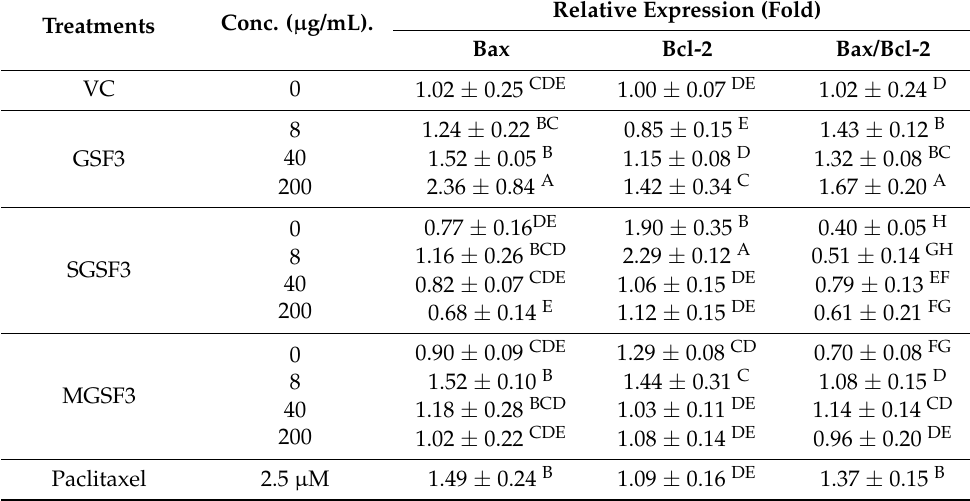
Table 1. Effects of GSF3 direct treatments and indirect immunotherapy using splenocyte conditioned media (SGSF3) and macrophage conditioned media (MGSF3) cultured with GSF3 on Bax and Bcl-2 mRNA expression levels in human prostate cancer PC-3